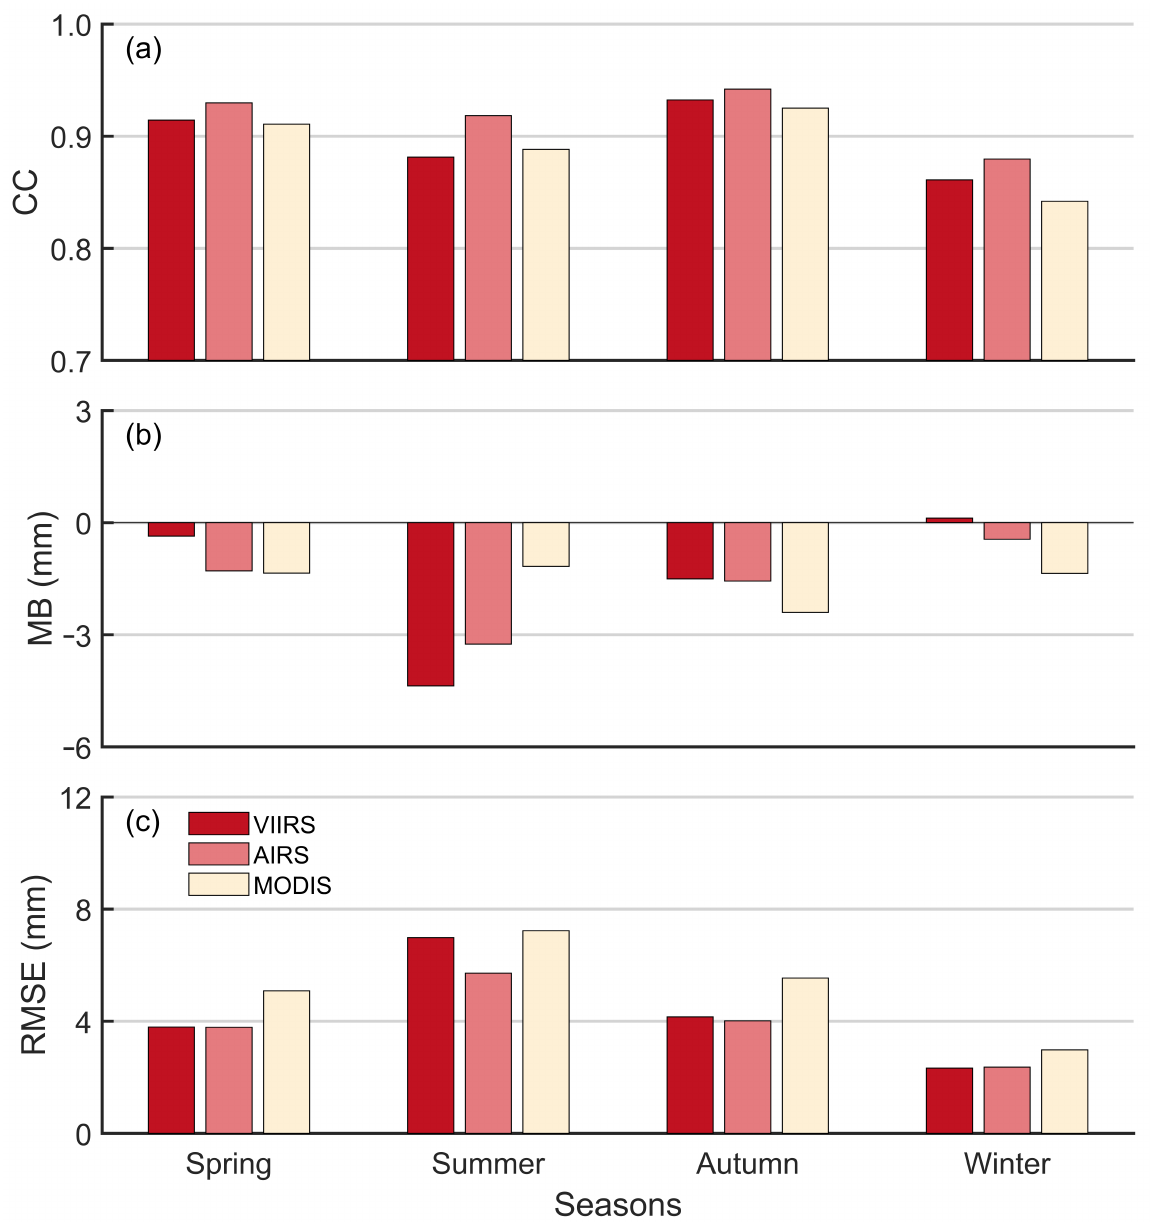
Figure 5. The mean values of three evaluation metrics (i.e., the CC ( a ), the MB ( b ), and the RMSE ( c )) of the PWV data derived from the remotely sensed water vapor products compared with the GPS-PWV within different seasons in mainland